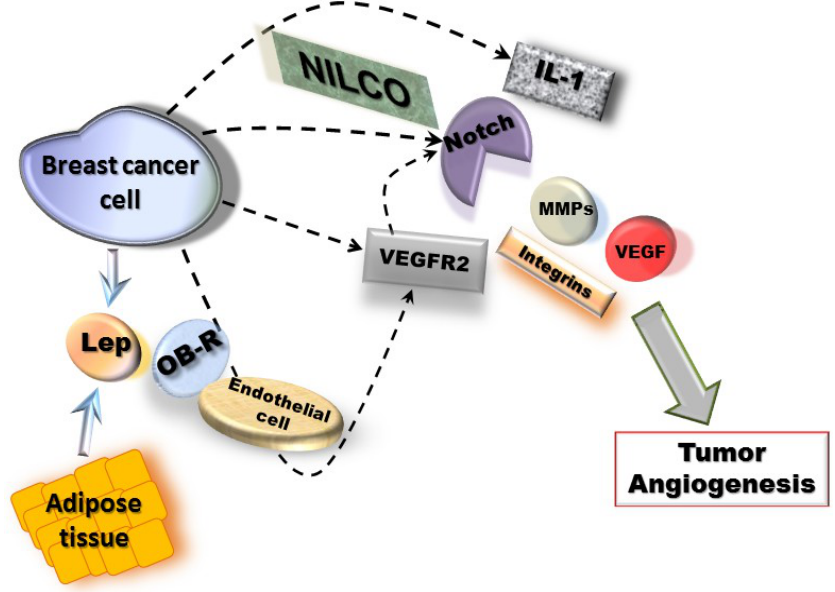
Figure 1. Mechanisms for leptin-induced effects in breast cancer angiogenesis . Leptin signaling could be linked to NILCO (Notch, IL-1, leptin crosstalk outcome) [116] and upregulation of pro-angiogenic factors (VEGF/VEGFR2, MMPs and integrins) [34,89]. These leptin